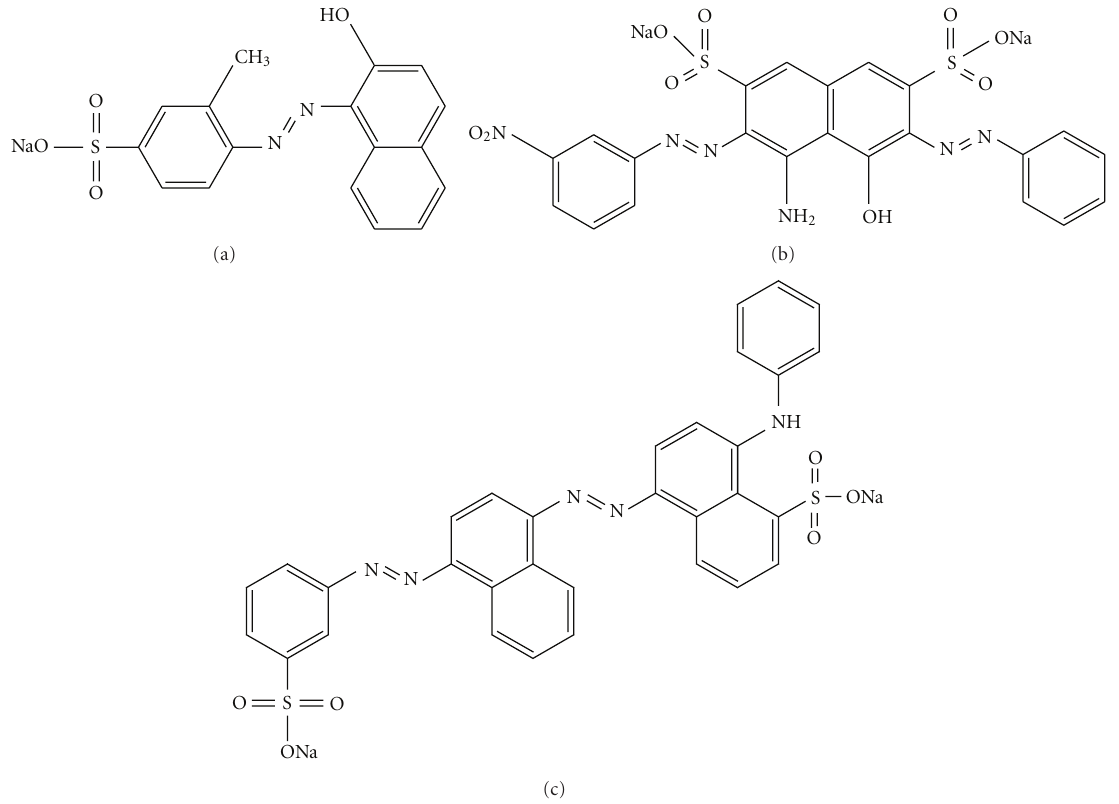
Figure 1: Chemical structure of (a) acid Orange 8; (b) acid Blue 29; (c) Blue